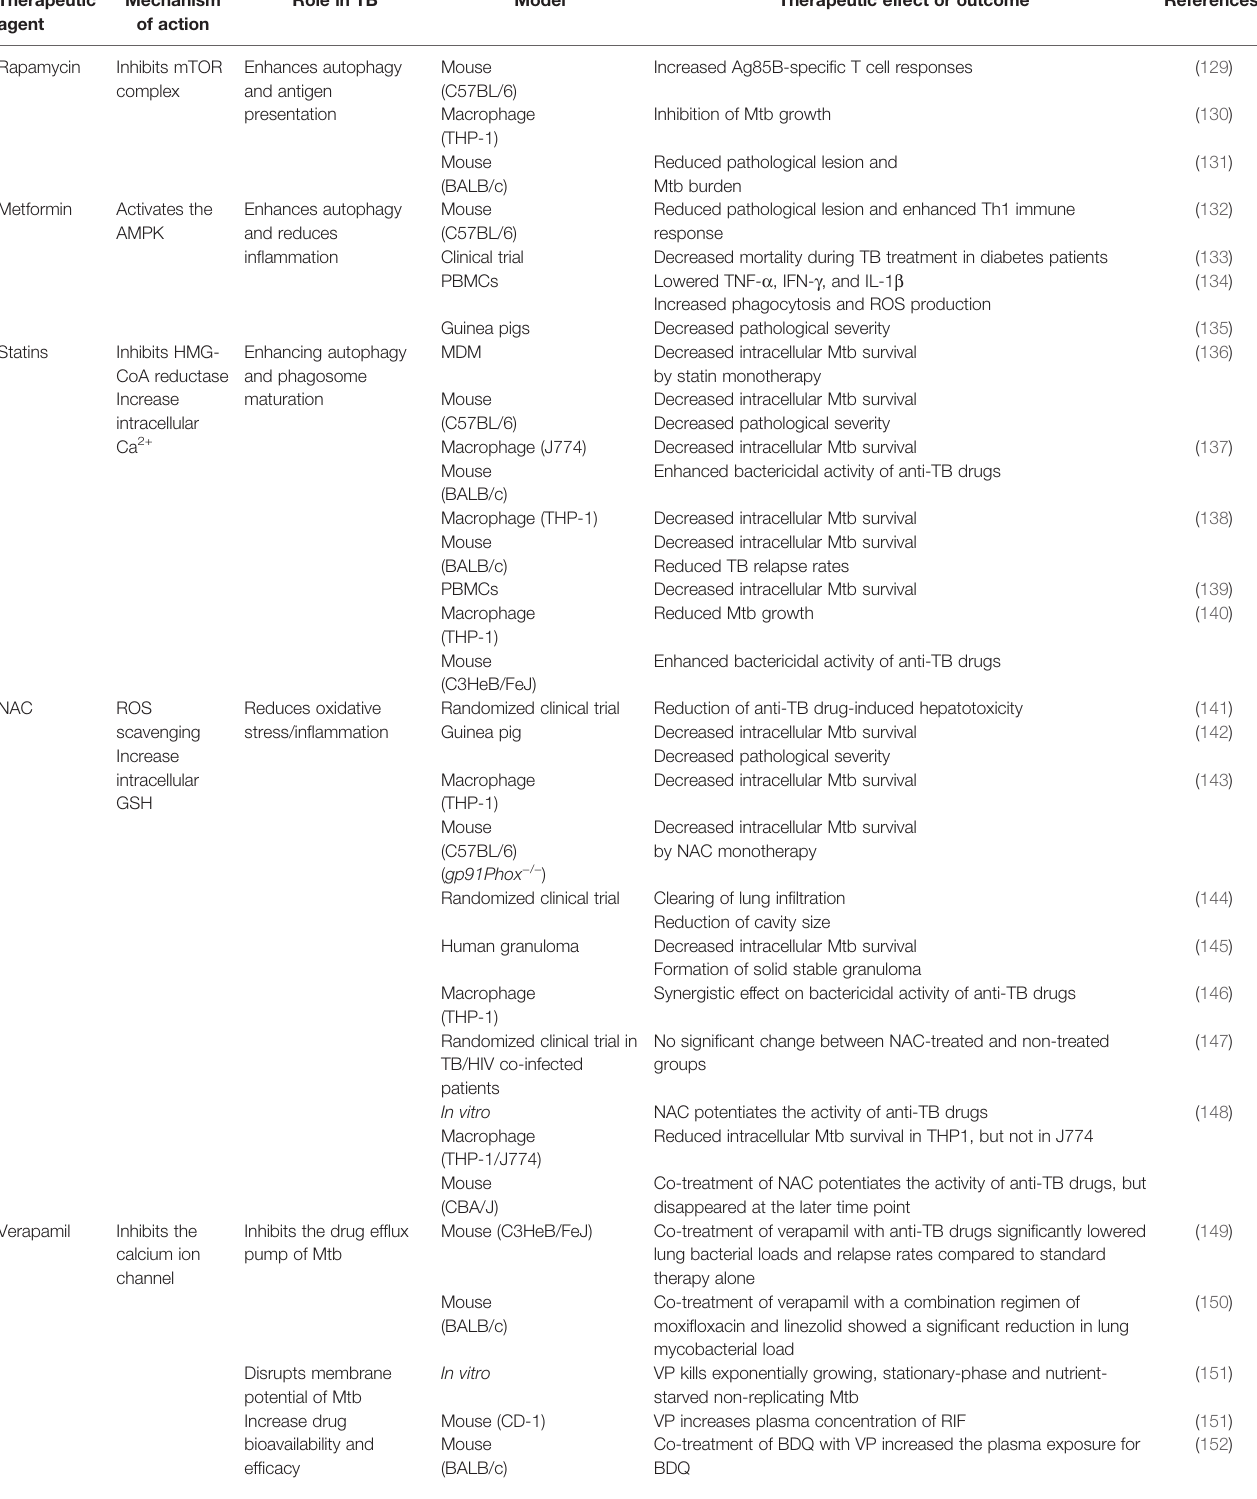
TABLE 1 | Effect of TB representative adjunctive therapeutic agents of anti-TB drugs on host